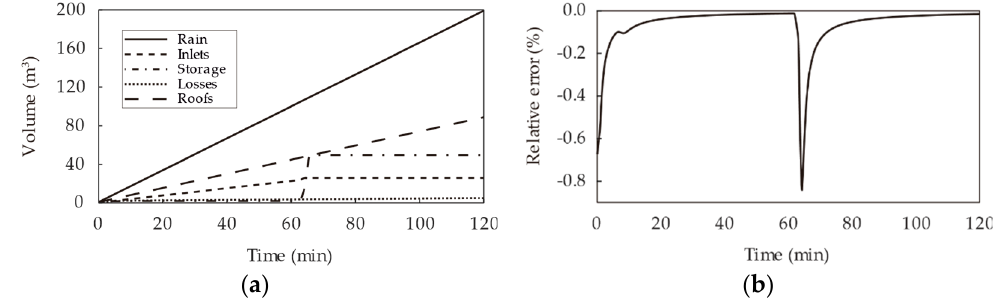
Figure 6. ( a ) Time series evolution of accumulative volumes; ( b ) mass balance error during the simulation for the simplified urban street.